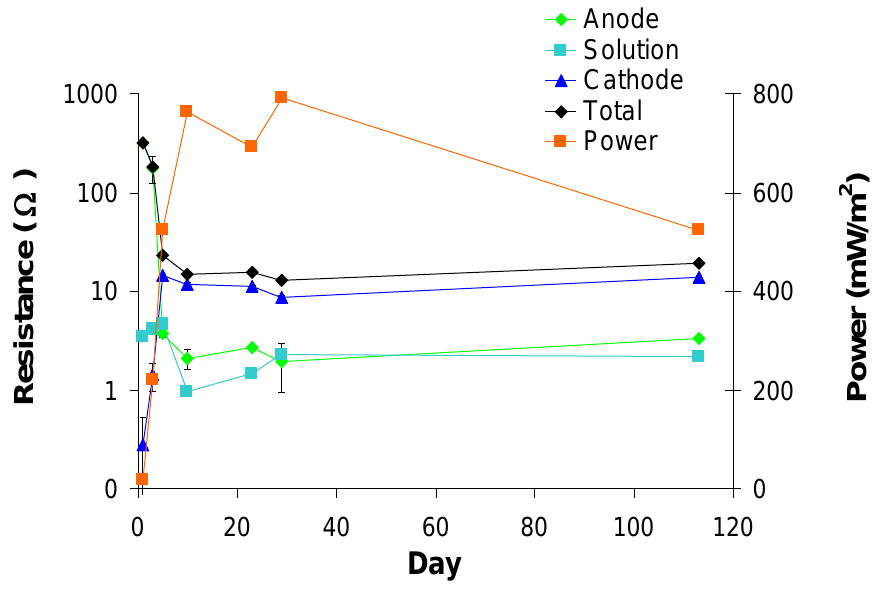
Figure 5. ECM analysis results for EIS data collected over 113 days of MFC